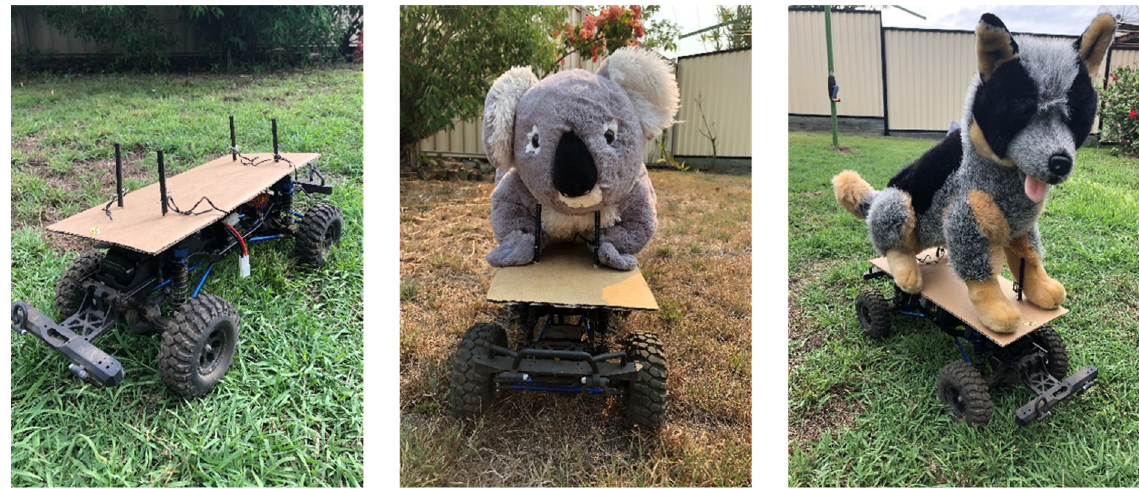
Figure 2. The three treatments (from left to right): Car, Koala and Dog, used to test the response of cattle to koala and dog models.